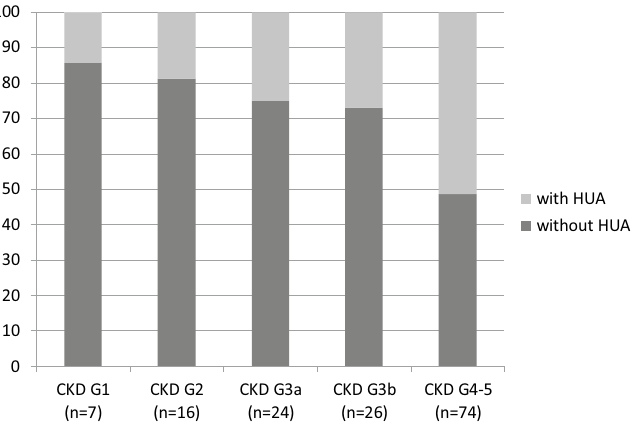
Figure 1. Proportion of patients with HUA for each CKD stage. The proportion of patients with HUA was 14.29% in CKD stage G1, 18.75% in CKD stage G2, 25.00% in CKD stage G3a, 26.92% in CKD stage G3b, and 51.35% in CKD stage G4-5. This was a significant difference among the CKD stages ( P = 0.013).